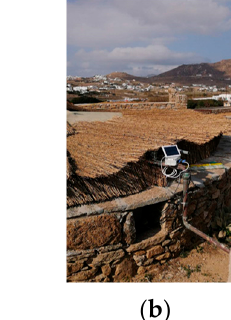
Figure 10. ( a ) Electrovalve for controlling the water flow; ( b ) Level sensor installed in one of the tanks.